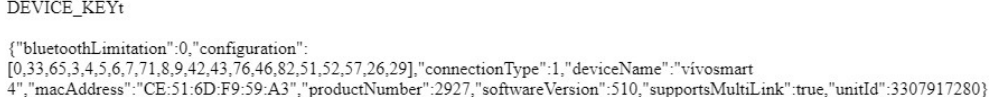
Figure 22. Garmin tracker